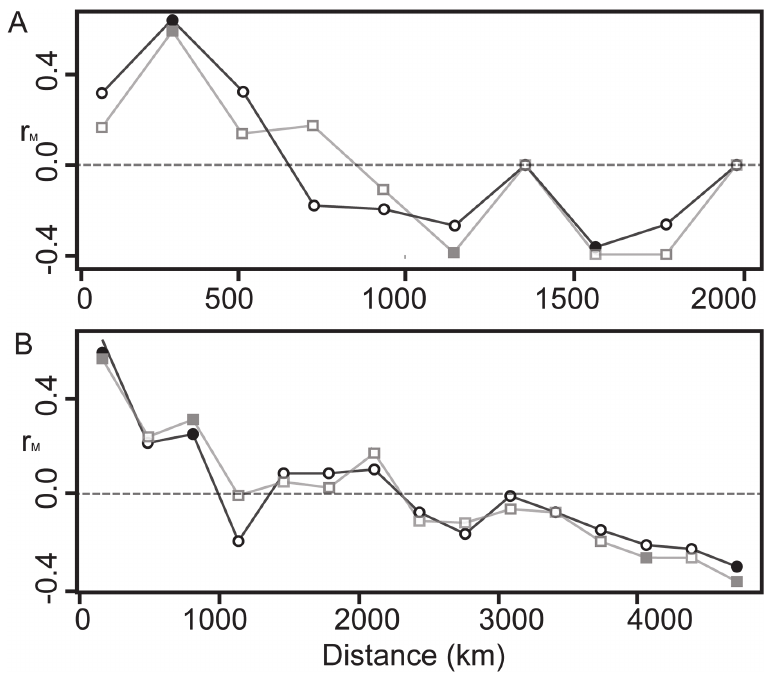
Fig 3. Isolation by distance of A . germinans and A . schaueriana . Mantel correlograms performed on approximated distances between each pair of sample locales along the coastline for A) A . germinans and B) A . schaueriana . Black interconnected circles refer to D [31], and gray interconnected squares indicate Nei ’ s genetic distance [69]. Filled squares and circles indicate significant correlations (p < 0.05) after 10,000